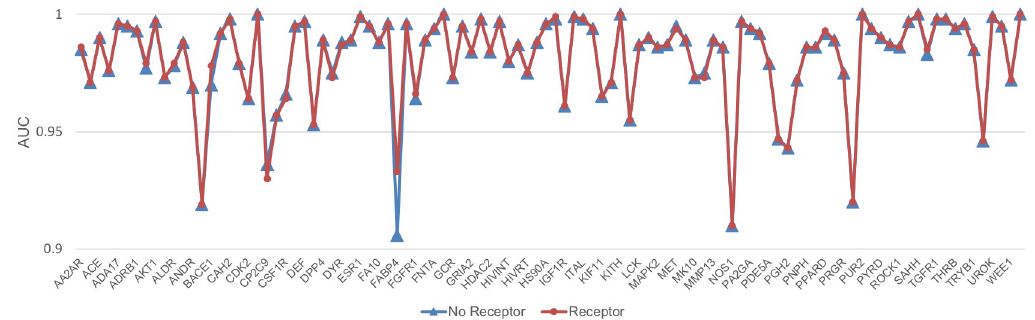
Fig 5. Performance of the receptor-ligand model for the same ligand test sets with and without receptor information. For each target, red dots indicate performance when the receptor structure was provided in the test set, while blue triangles indicate performance when the receptor structure was replaced by a single dummy atom. The x-axis displays each DUD-E target in the same order as they appear in the DUD-E database (http://dude.docking.org/targets). The targets with even indices are not labeled on the x-axis due to space limitations.